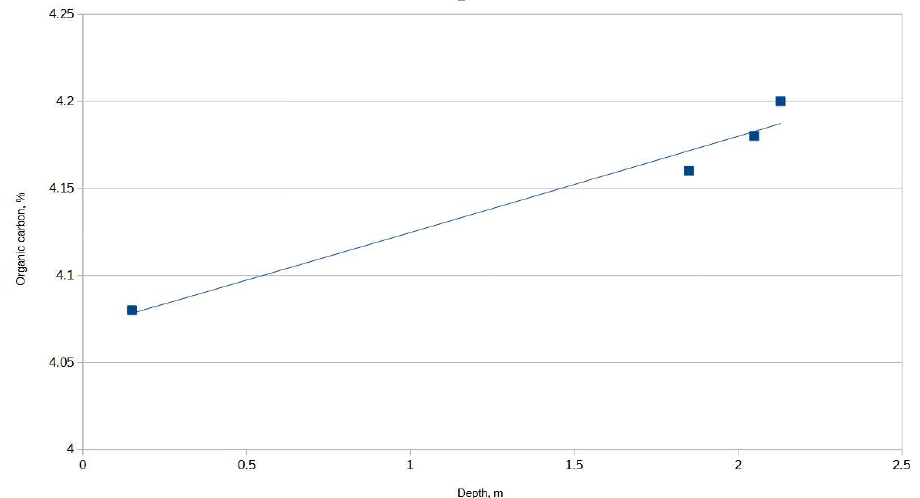
Figure 15. Mykolyna Broiaka. Organic carbon content in soil-section 1. Analysis by H.P. Zadverniuk. Elaboration—DK.